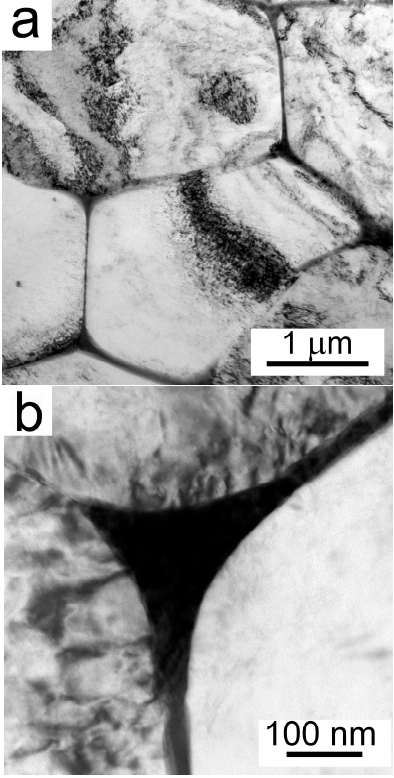
Figure 7. The microstructure of an atomized powder particle Al7075Zr_A, ( a ) cell interiors; ( b ) boundary region.